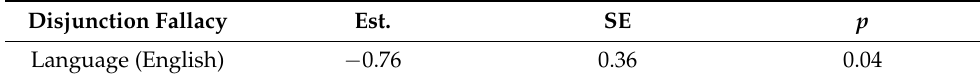
Table 15. Disjunction fallacy regression by language.